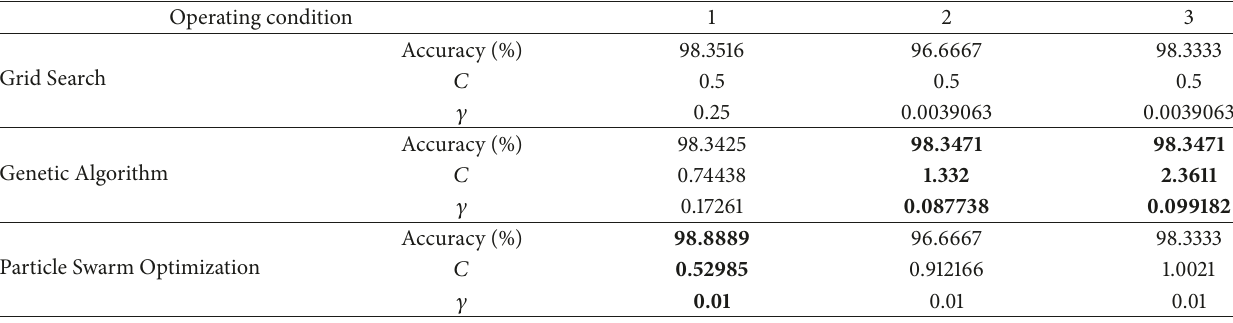
Table 6: Results of parameter optimization.